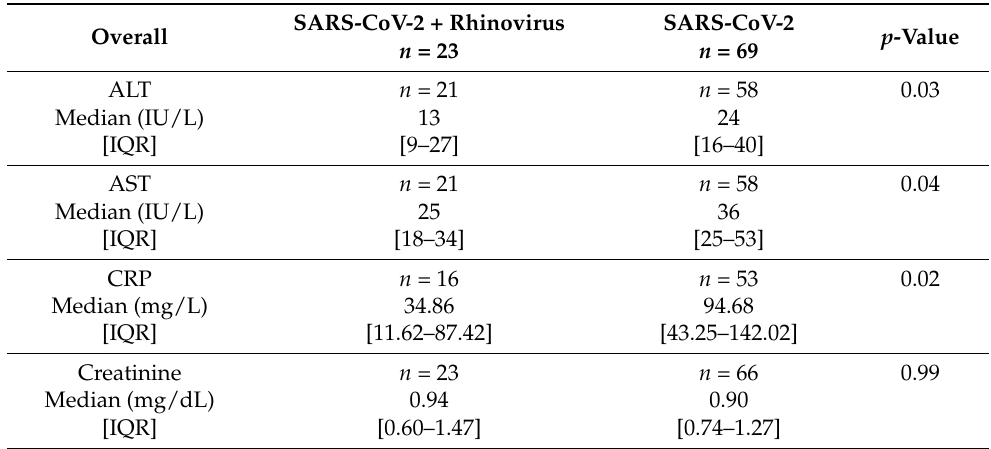
Table 5. Laboratory biomarkers on day of specimen collection between patients with SARS-CoV-2 + rhino- virus infection or SARS-CoV-2 mono-infection